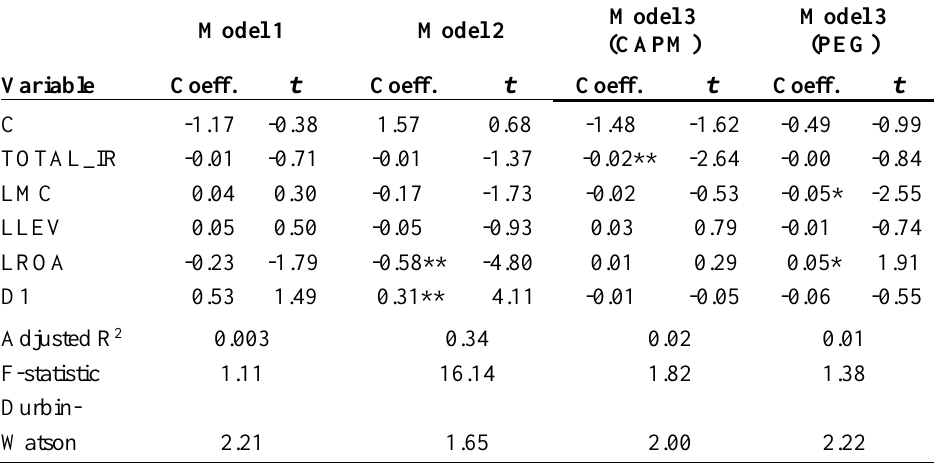
Table 4: Regression